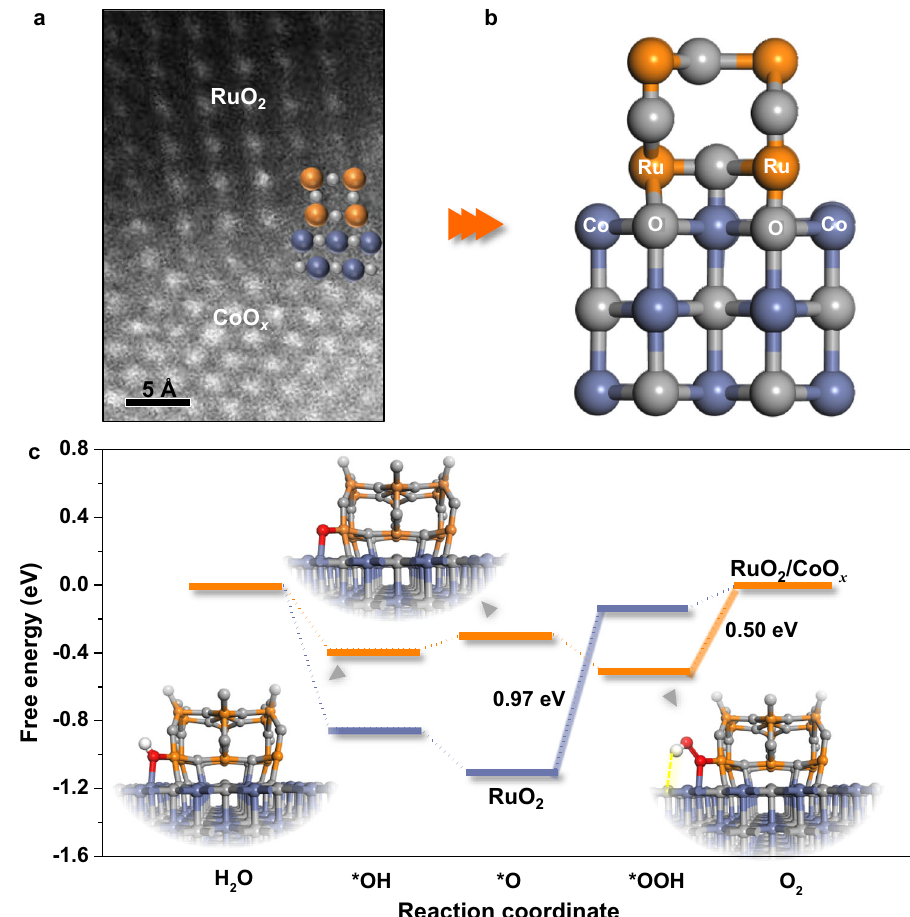
Fig. 5 | Theoretical study on origin of enhanced activity on RuO2/CoO x . a HADDF-STEM characterization of RuO 2 /CoO x interface exposed active sites. b Schematic diagram of the structure model of RuO 2 /CoO x hybrid catalyst. c Calculated OER free energy diagrams for RuO 2 and RuO 2 /CoO x , with the inset